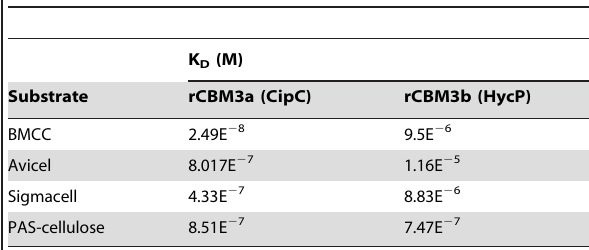
Table 1. Dissociation constants of rCBM3a and rCBM3b to cellulosic